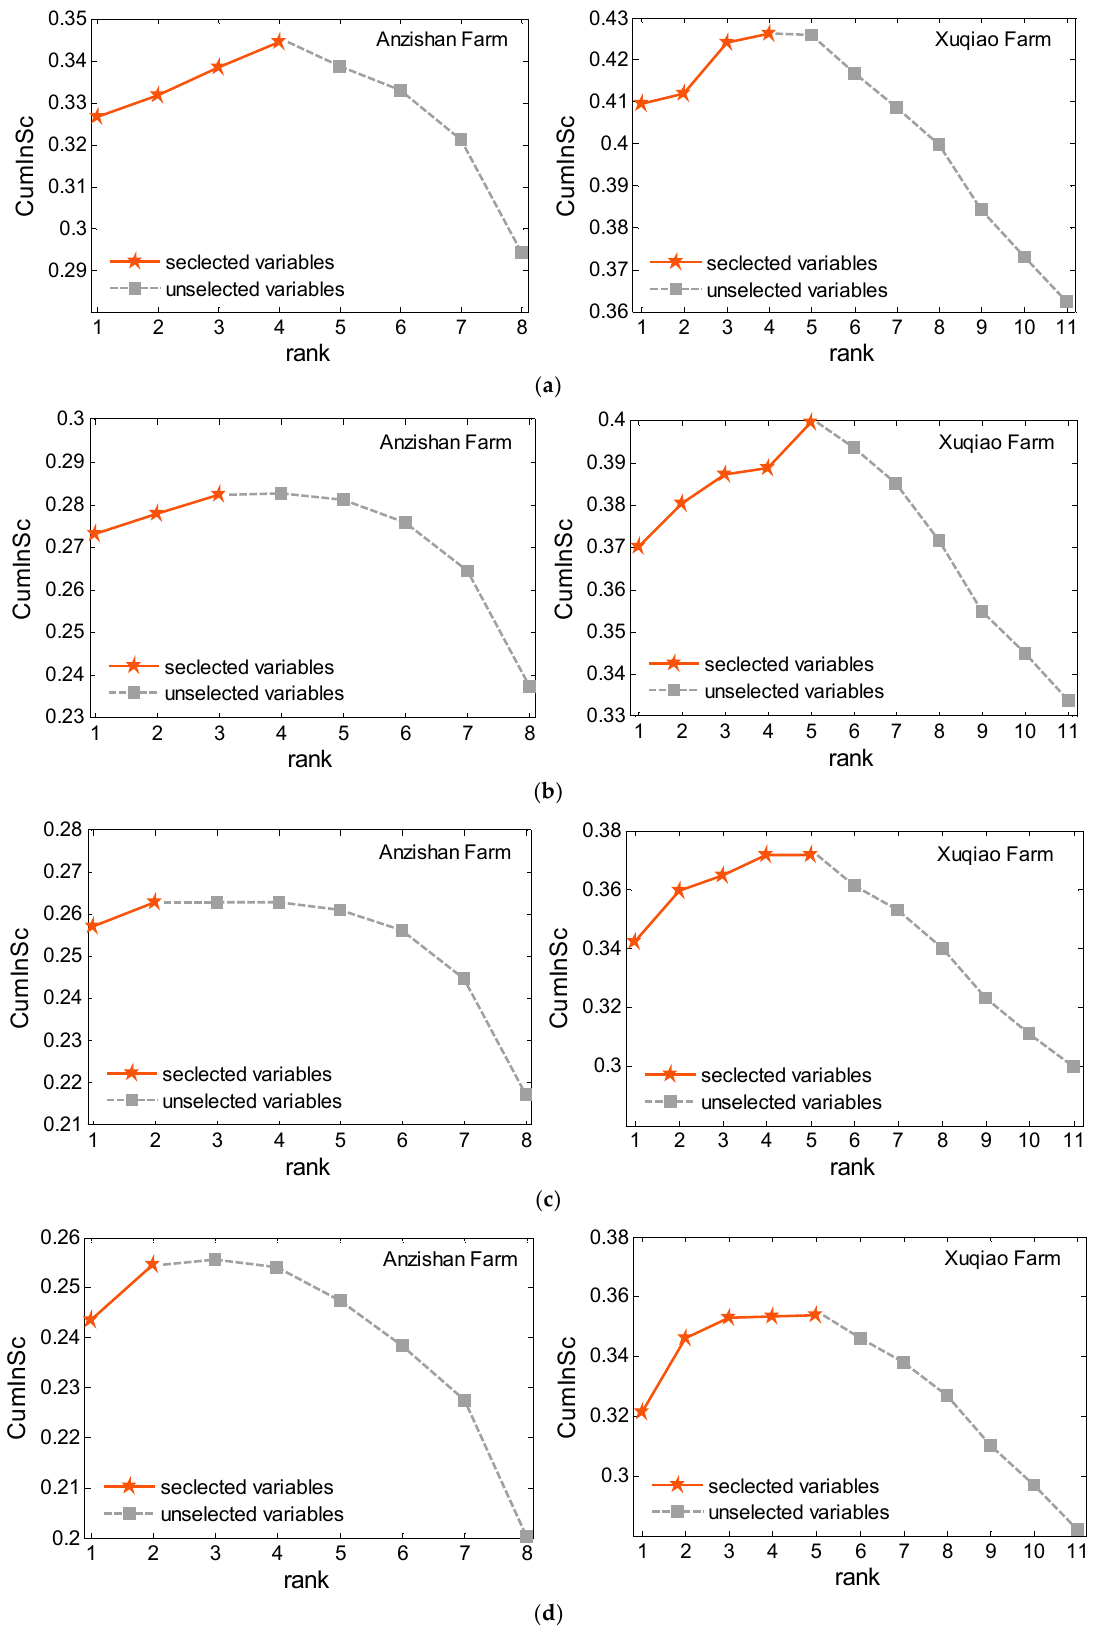
Figure 5. Cumulative informativeness score curve for IVS of Anzishan and Xuqiao farms: ( a ) one-hour ahead prediction; ( b ) two-hour ahead prediction; ( c ) three-hour ahead prediction; and ( d ) four-hour ahead prediction . Table 1. Ranking and selection of candidate variables for Anzishan Farm.